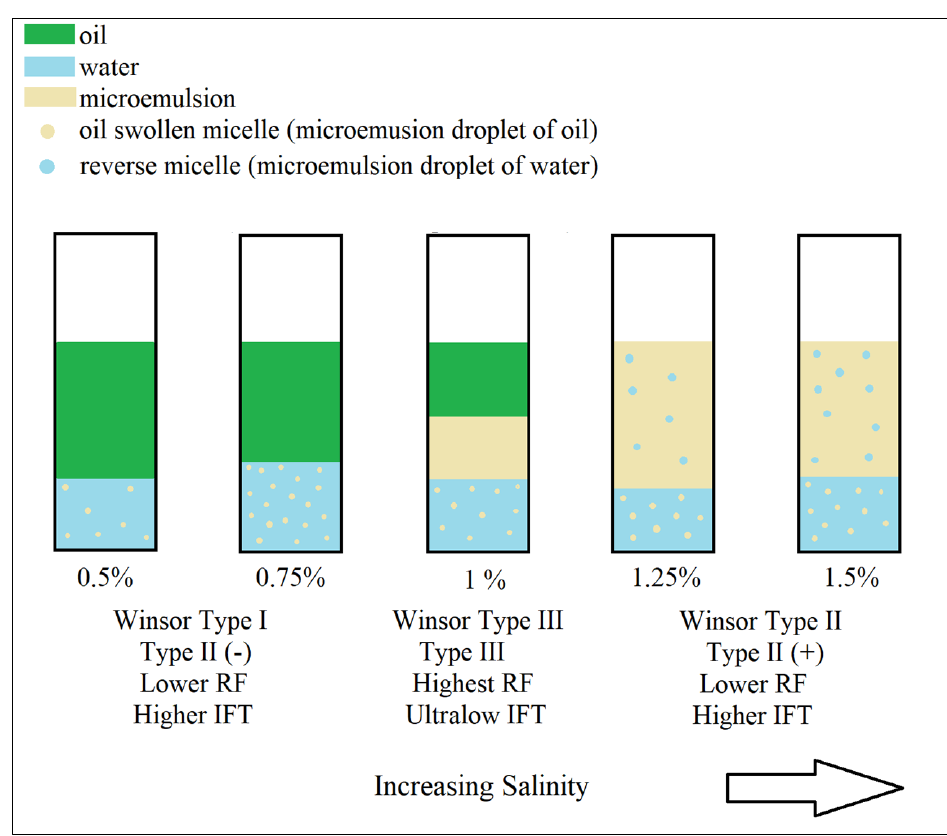
Figure 10. Schematic illustration of middle phase formation and microemulsion phase transition as a function of salinity.